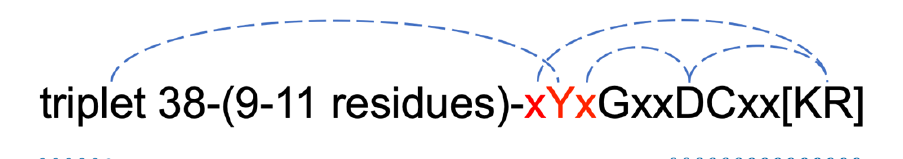
Figure 8. Interactions between a matrix loop and the conserved MCF motif. Electrostatic interactions are highlighted with blue dash lines. A residue is shown by a red letter if it is involved in the interactions through its backbone